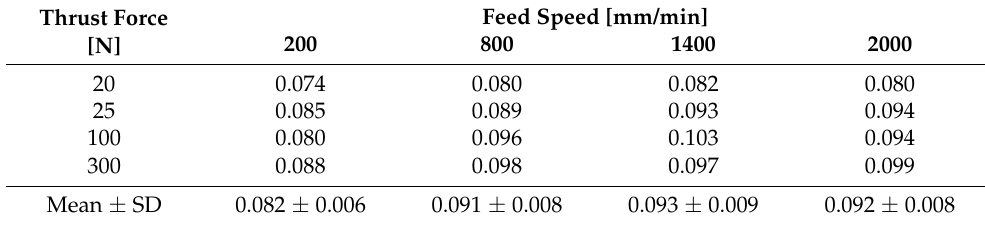
Table 3. Coefficients of friction as function of normal force and feed